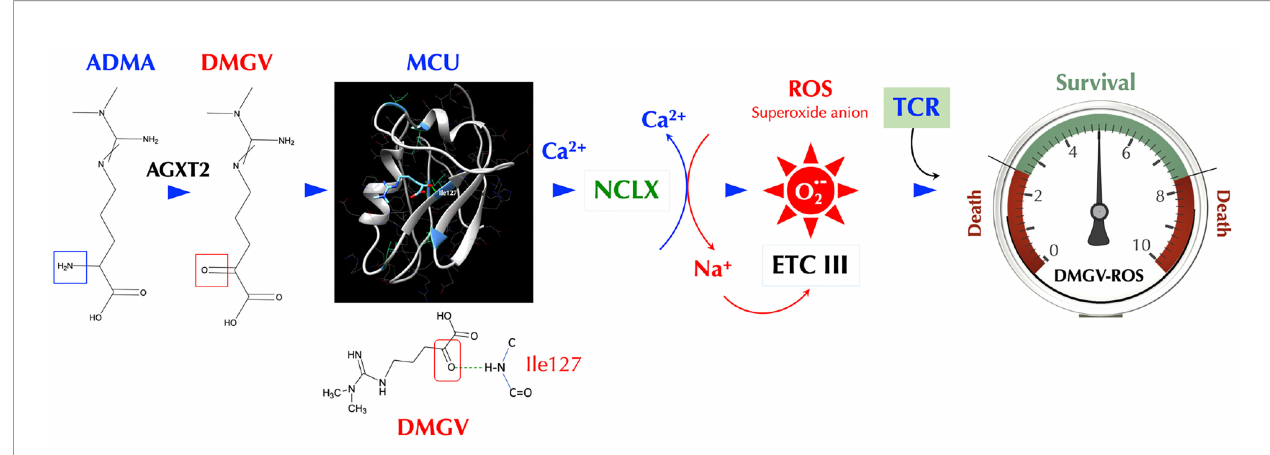
FIGURE 7 | DMGV is a rheostat of T cell survival. When ADMA (or SDMA) is converted to DMGV by AGXT2 in the mitochondria, DMGV binds to MCU via a hydrogen bond at Ile127 and activates it to induce calcium import to the mitochondria, which triggers ER to release calcium. A rapid calcium ion rise in the mitochondria activates NCLK which exports calcium ions out of and imports sodium ions into the mitochondria. Sodium ions (positive charge) bind to the inner lea fl ets of the mitochondrial membrane (negative charge), which makes the membrane rigid and restricts the movement of semiquinones. This uncouples the Q cycle by trapping semiquinones in the Complex III Q0 site, thus generating superoxide anions (45). There is the range of AGXT2-DMGV-MCU-ROS levels that support survival and expansion of T cells while T cells do not survive outside that